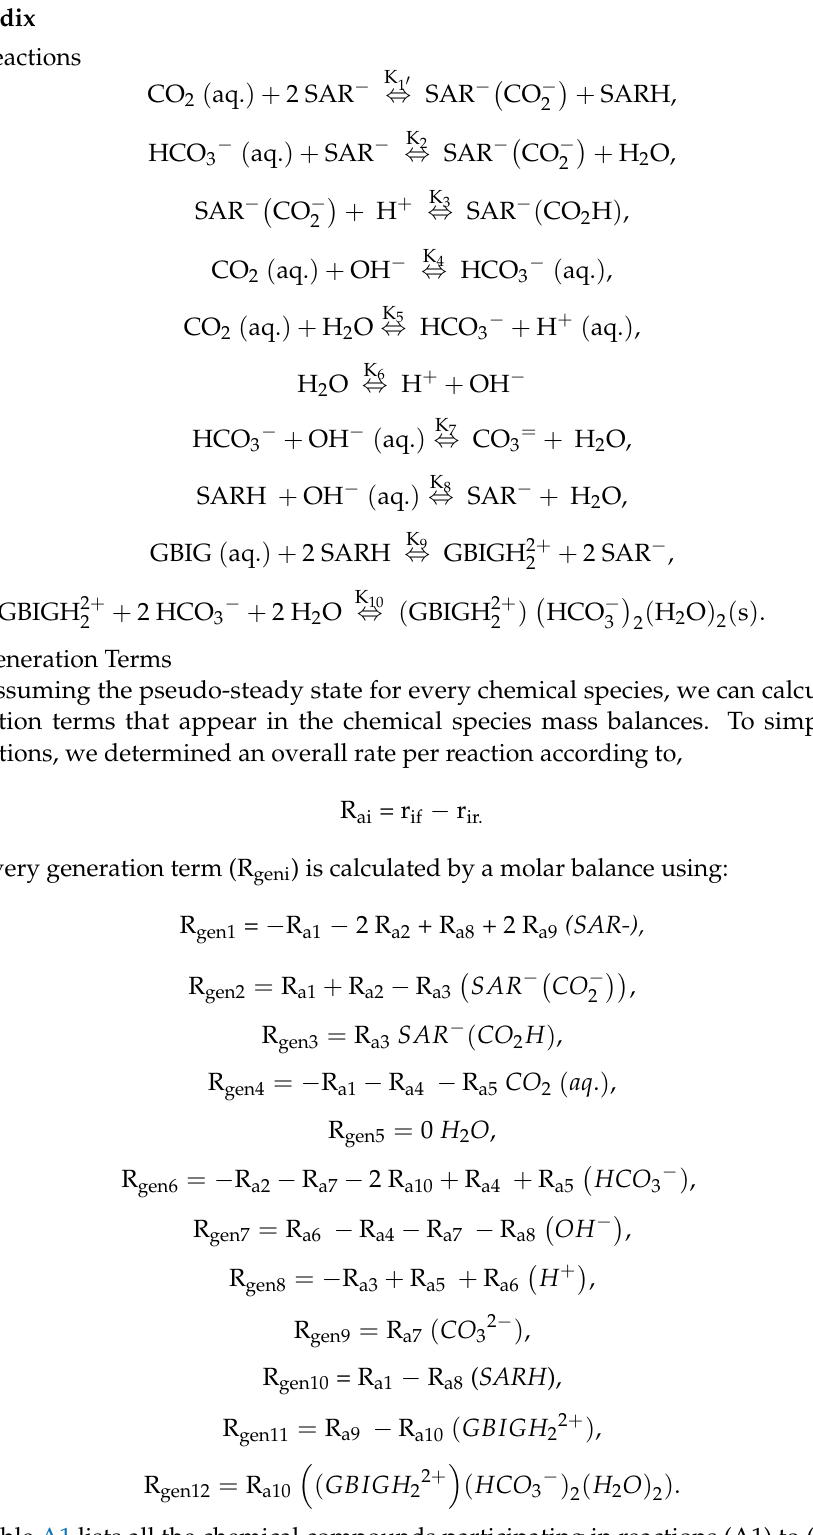
Table A1 lists all the chemical compounds participating in reactions (A1) to